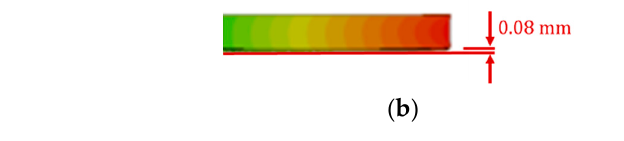
Figure 7. Numerically Predicted Warpage for 3D Printed Samples at Different Layer Heights ( a ) 0.15 mm ( b ) 0.10 mm.